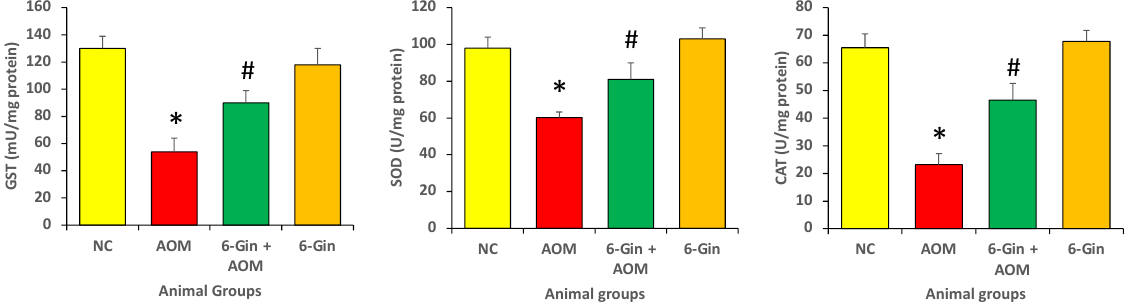
Figure 1. The protective effect of 6-Gingerol on the azoxymethane-induced colon carcinogenesis through enhancement of antioxidant enzyme levels. Data are represented as ± standard error of mean (SEM). The different groups are NC as normal control, AOM as azoxymethane treatment group (disease control), 6-Gin + AOM as 6-gingerol treatment to disease control and 6-Gin as only 6-gingerol treatment group. The * indicates significant difference ( p < 0.05) between disease control vs. normal control and # indicates significant difference ( p < 0.05) between disease control and disease control with treatment.